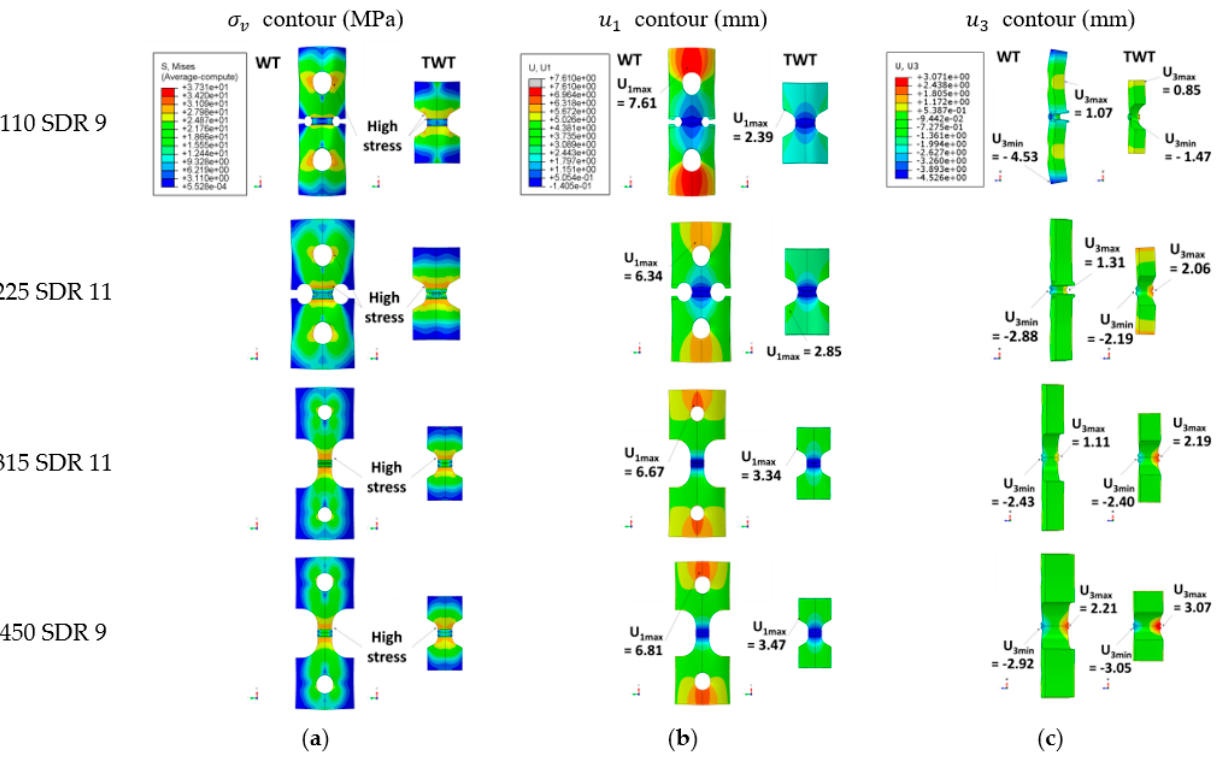
Figure 14. FE analysis results at F max : ( a ) 𝜎 (cid:3049) ; ( b ) 𝑢 (cid:2869) ; ( c ) 𝑢 (cid:2871) contours.